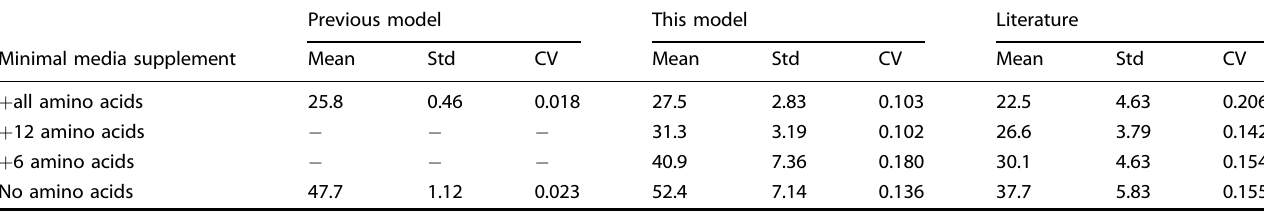
Table 1. Comparison of growth rates in various media conditions between the model and values reported in